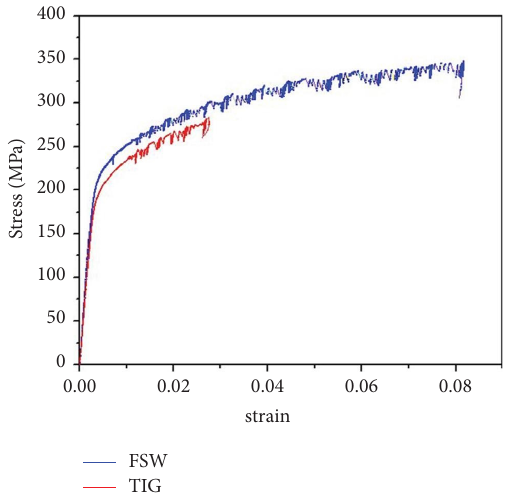
Figure 8: Stress and strain graph for TIG and FSW weld